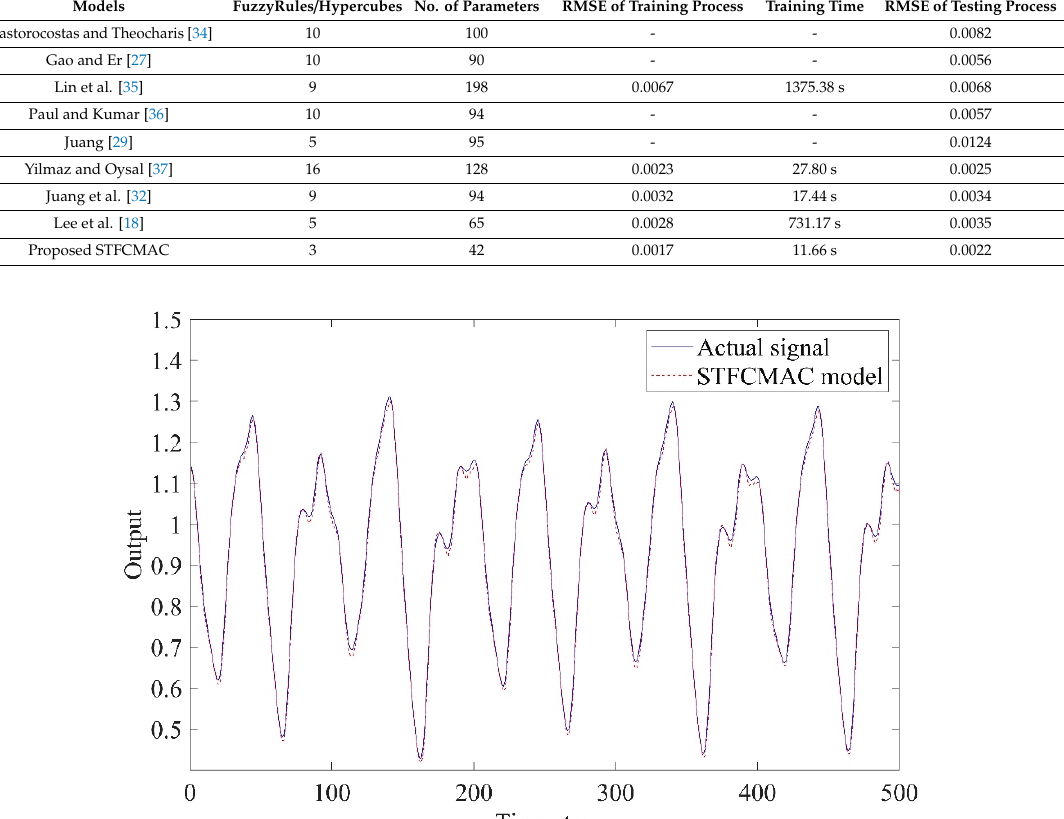
Figure 11. The prediction errors of chaotic time series obtained using the STFCMAC model. 6. Conclusions This study proposes a STFCMAC model with structure and parameter learning to solve identification and prediction problems, in which a simultaneous structure and parameter learning algorithm are proposed. Moreover, in the structure learning scheme, no initial structure exists in advance. That is, the proposed structure learning scheme can automatically determine the required structure of a network. Therefore, the proposed STFCMAC model has three advantages: (1) The proposed model requires less memory and fewer hypercubes/fuzzy rules. (2) The proposed model has a lower RMSE value. (3) The proposed model determines the number of hypercubes/fuzzy rules using the prespecified threshold value. Inevitably, the proposed model has limitations. For example, determining a predetermined threshold value depends on user experience or trial and error. Therefore, an adaptive threshold selection in the STFCMAC model will be considered in future research. At the same time, in order to achieve high-speed operation in real-time applications, the STFCMAC model will be also implemented on a field programmable gate array in future research.